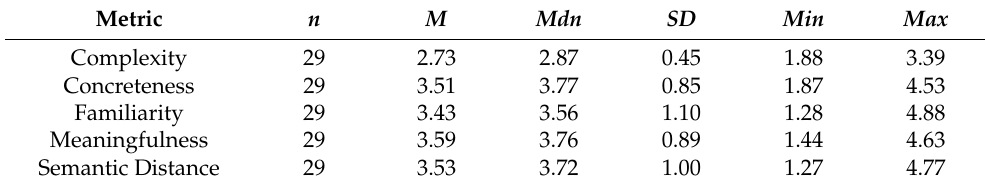
Table 5. Descriptive statistics for the five icon characteristics across all 18 icons and 29 pilots.